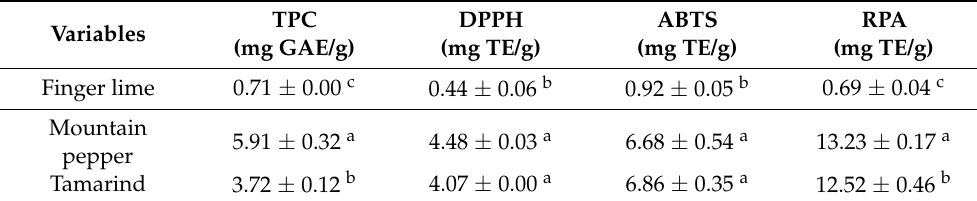
Table 1. Estimation of total phenolic content (TPC) and antioxidant activities of finger lime, mountain pepper and